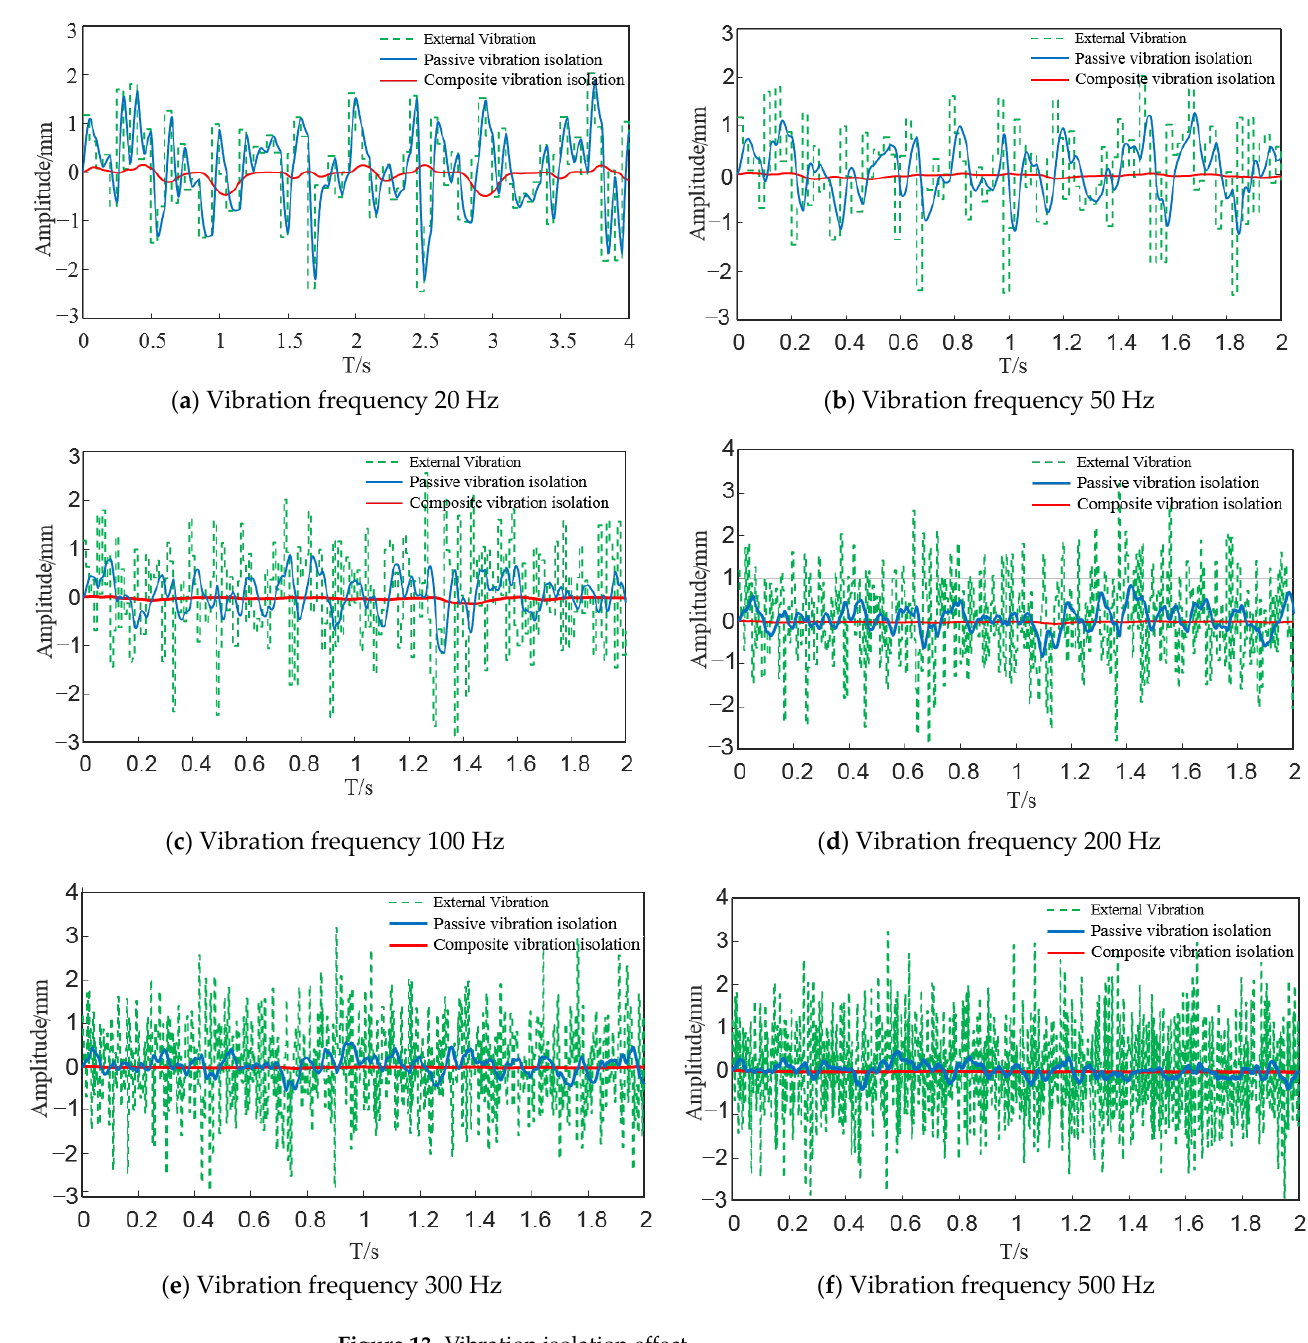
Figure 14. Photograph of PECVIS test platform. Table 10. Vibration isolation effect of mechanical spring and PECVIS. External Vibration Frequency (Hz)